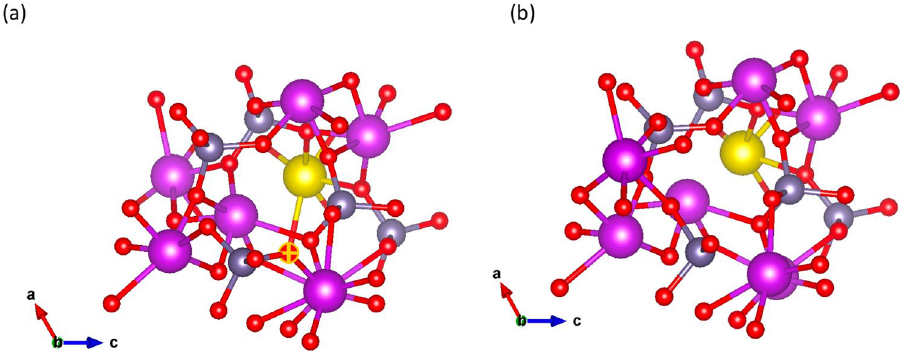
Figure 6. Arrangement of atom around REE atom ( a ) before O vacancy ( b ) after O vacancy. The yellow ball depicts Pr atom and marked O is the atom removed.